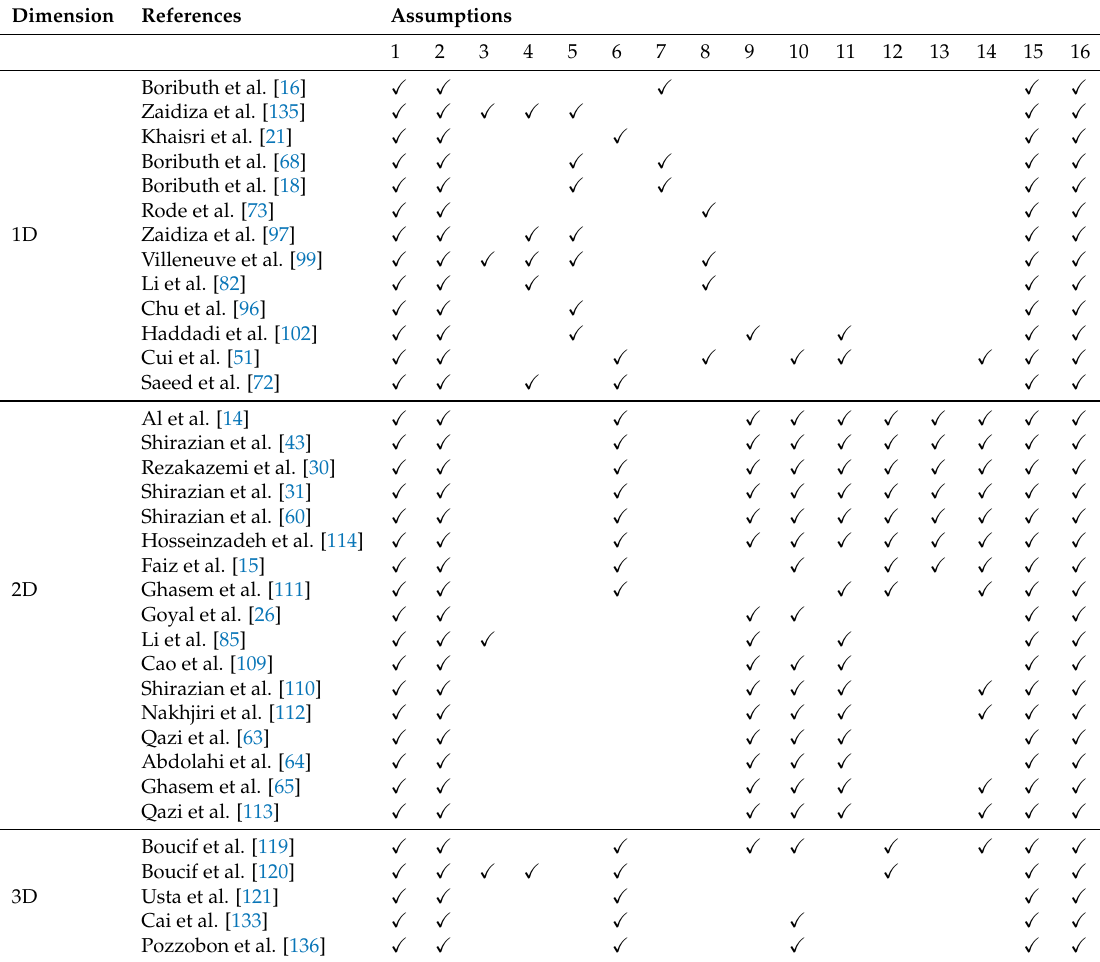
Table 5. State-of-the-art HFMC models for PCC organized by dimensionality. Modeling assumptions (listed in the text) are checked for each model to enable comparison. Dimension